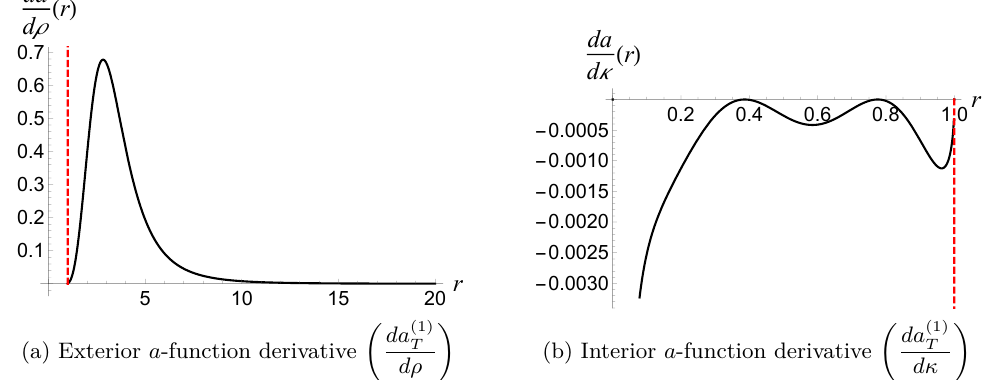
Figure 2 . Plots of the derivative of the a -function with respect to the energy scale (4.18) in the holographic p -wave superfluid state of [24]. In the exterior ( Λ = ρ ), the derivative is positive, so the a -function indeed monotonicially decreases with energy. Furthermore, the derivative goes to 0 both at r → ∞ and r = r h , in agreement with these being, respectively, the UV and IR fixed points. In the interior ( Λ = κ ), note that the derivative does not obviously go to 0 at r = r h due to numerical instability, but it is negative as expected. Additionally, it undergoes nontrivial oscillations before apparently diverging, unlike in the free Kasner flows of [10]. It is possible that the local maxima are fixed points of the trans-IR